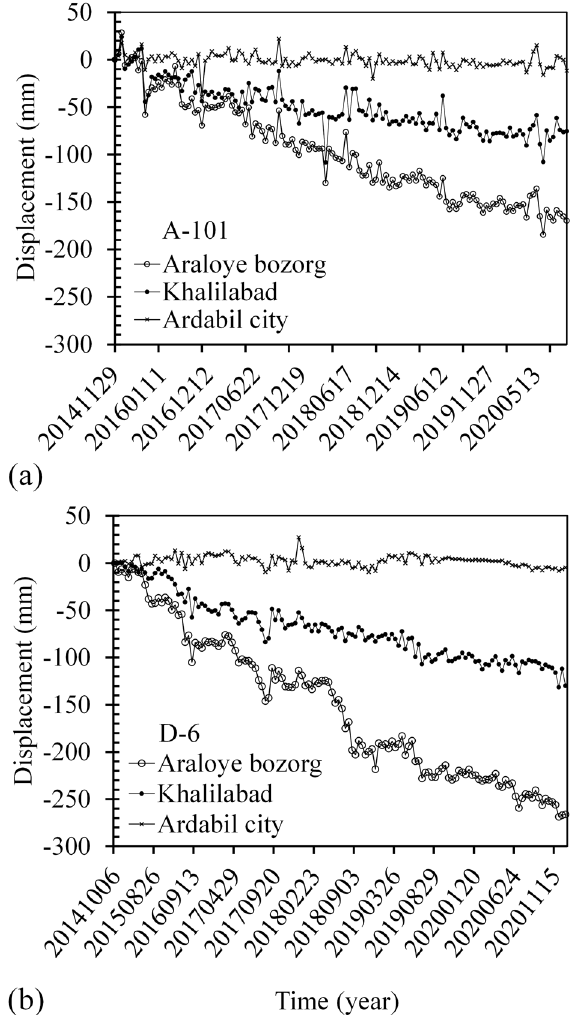
Figure 7. Displacement time-series from S1A images at three representative locations. ( a ) From October 2014 to January 2021 for D-6 track and, ( b ) From November 2014 to September 2020 for A-101